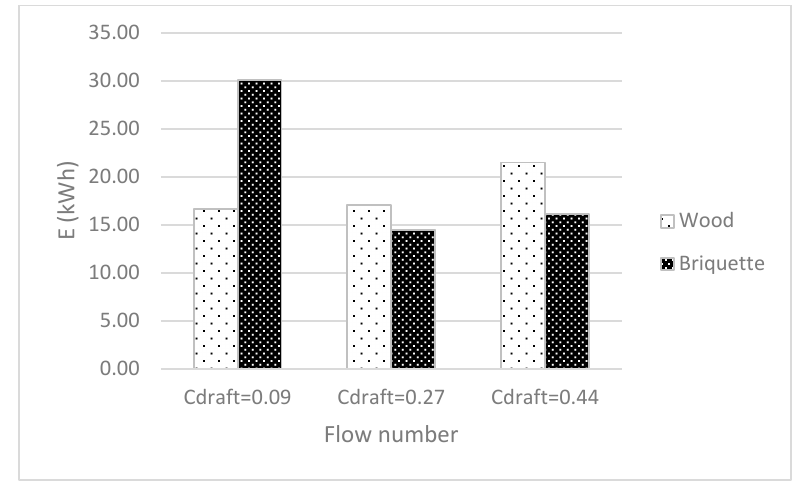
Figure 10. Average energy yields for different fuels.